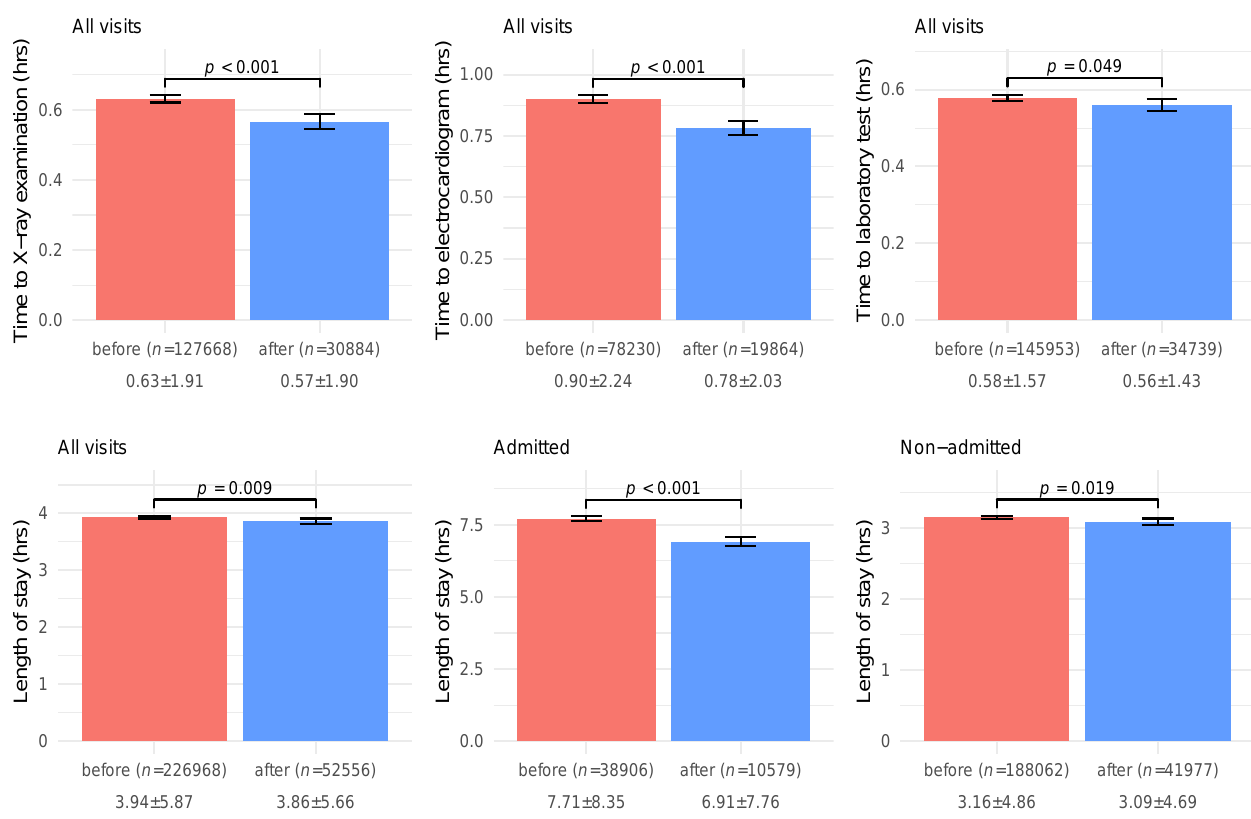
Figure 2. Comparisons of wait time before and after the start of the COVID-19 pandemic. The bar chart and error bar demonstrate the mean and corresponding 95% conference intervals, and the p -value is tested by Student’s t -test. The annotations below bars are the number of patients and mean ± SD